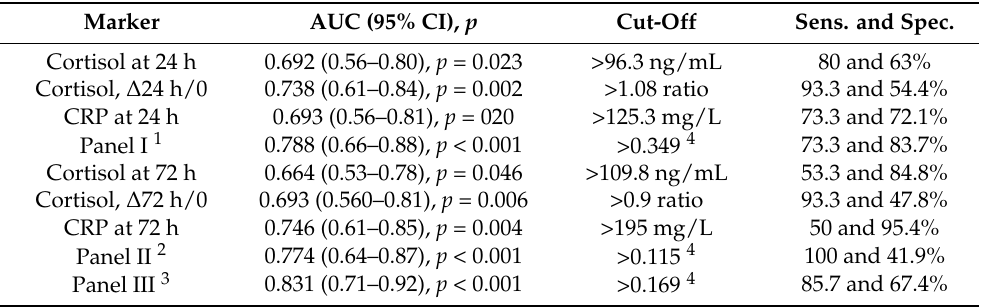
Table 3. Cortisol and C-reactive protein (CRP) as markers of surgical site infections (SSI). Marker AUC (95% CI), p Cut-Off Sens. and Spec.